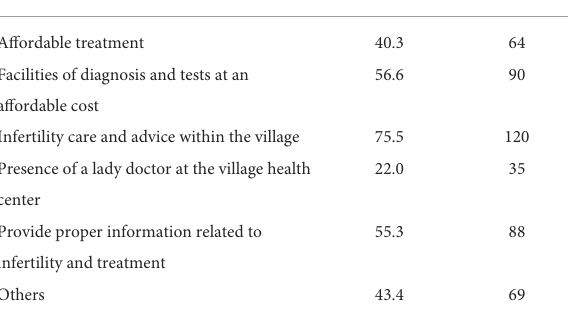
TABLE 6 Percentage of women mentioned services needed for couples with infertility problem. Services needed for women